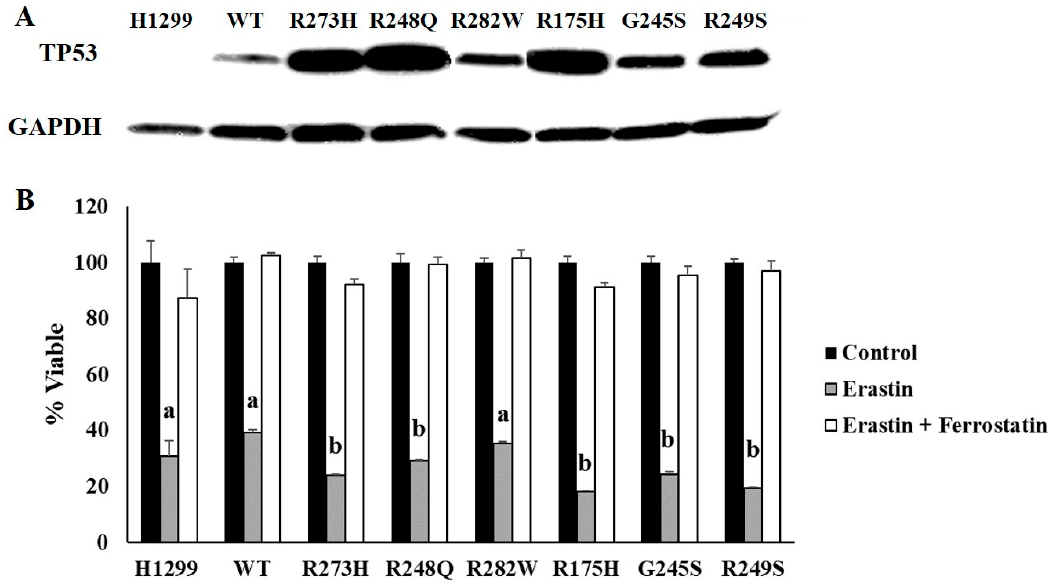
Figure 1. TP53 mutation status influences ferroptosis sensitivity. H1299 (TP53 null) cells were transfected with either a tetracycline inducible wild-type (WT) TP53 or a representative contact (273H, 248Q, 282W) or conformational (175H, 245S, 249S) mutant TP53. ( A ) Tetracycline-inducible expression of WT and mutant TP53 expression was confirmed by Western blot. Glyceraldehyde 3- phosphate dehydrogenase (GAPDH) was used as a loading control. ( B ) Cell viability measured following 24 h of treatment with DMSO (Control), 10 µM erastin, or 10 µM each of erastin and ferrostatin-1 ( n = 4 per cell type and treatment group). Superscripts ( a,b ) denote statistical significance, p < 0.05. Treatments that share the same superscripts are not significantly different. Error bars indicate SEM.